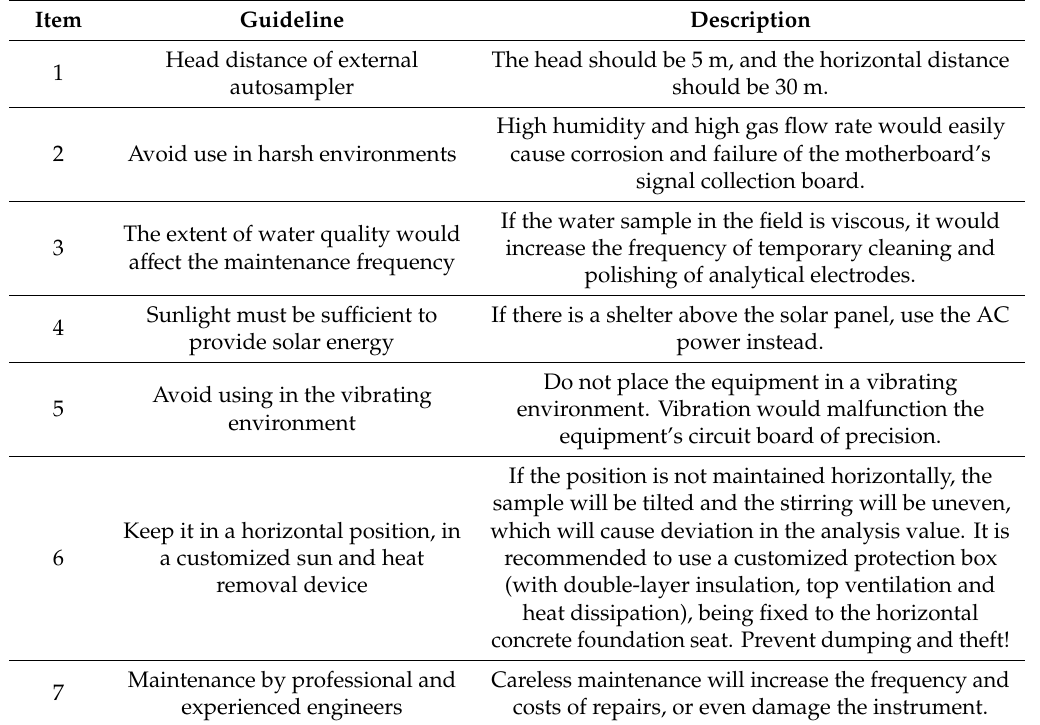
Table 3. Recommendations for operations of heavy metal monitoring